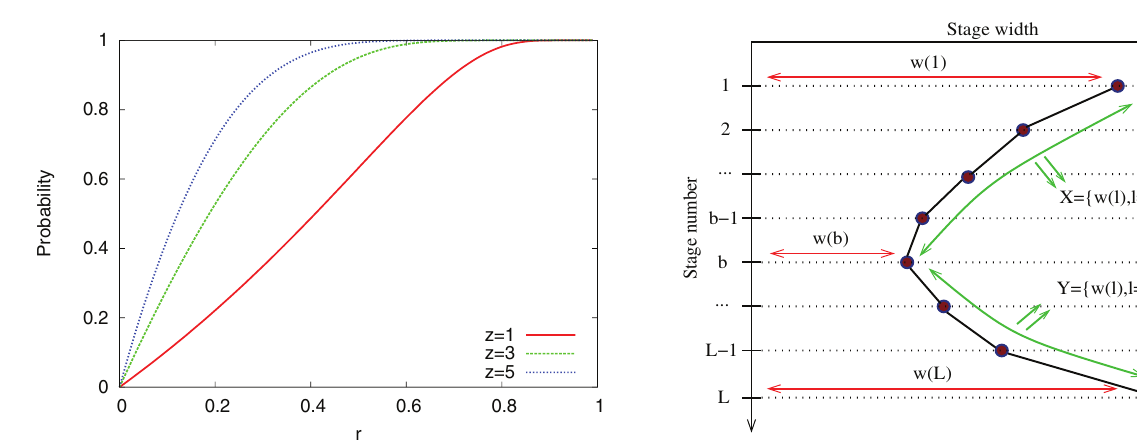
Figure 2. Probability of Regulatory Failure (RF) for three values of the parameter z . r is the fraction of upstream regulating edges that are lost due to a DL or RW